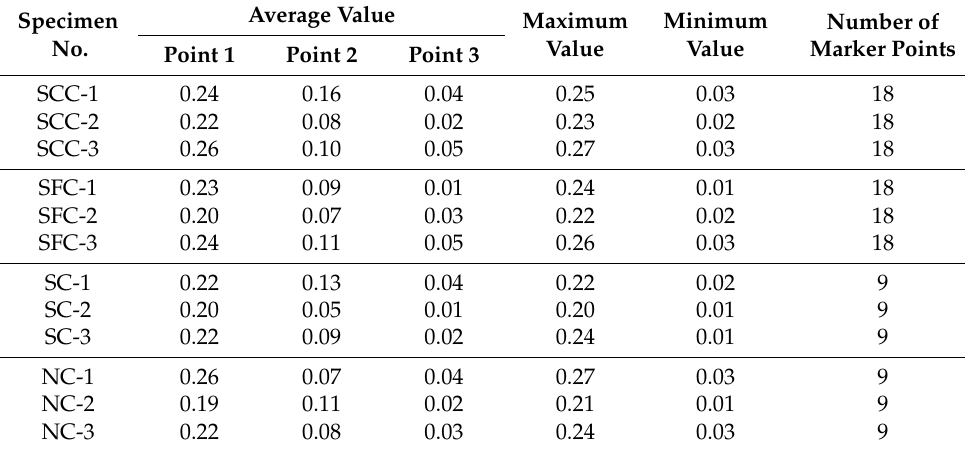
Table 5. Specimen pre-set crack width calibration